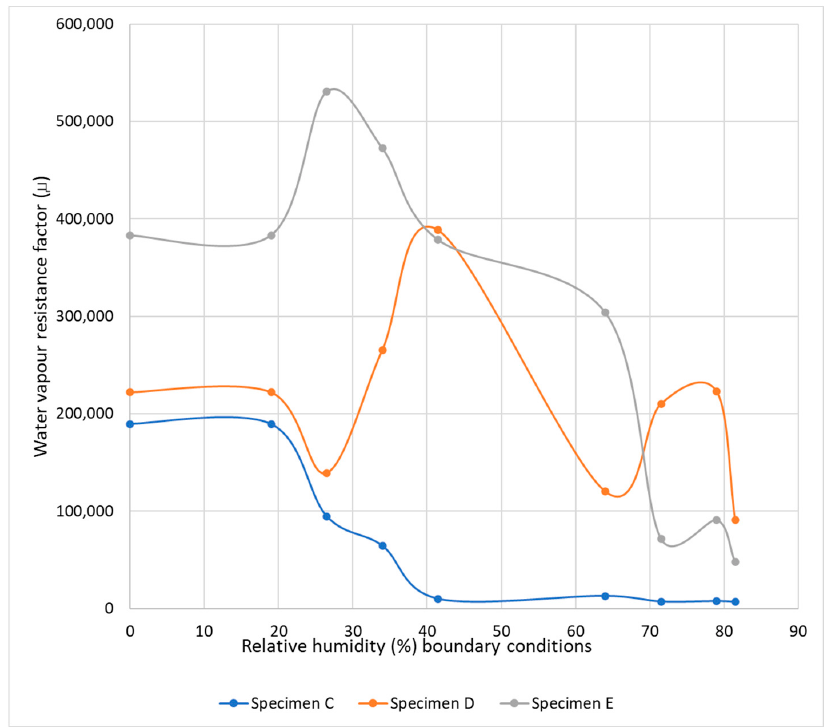
Figure 1. Plot of resistance factor against relative humidity prior harmonic curve adjustment for the three specimens.